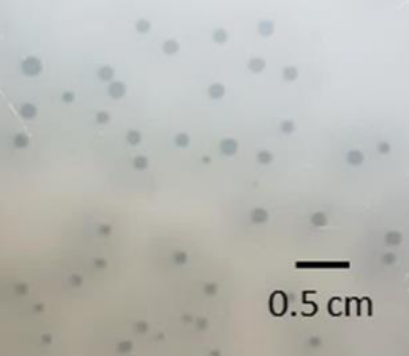
Figure 2. Phage PMBT5 plaques formed on an Eggerthella lenta DSM 15644 lawn in Wilkins–Chalgren Anaerobe Broth after 24 h incubation under anaerobic conditions. The plaques were lightly turbid and ranged from 1 to 2 mm in diameter and were surrounded by a halo (max. diameter 4 mm).